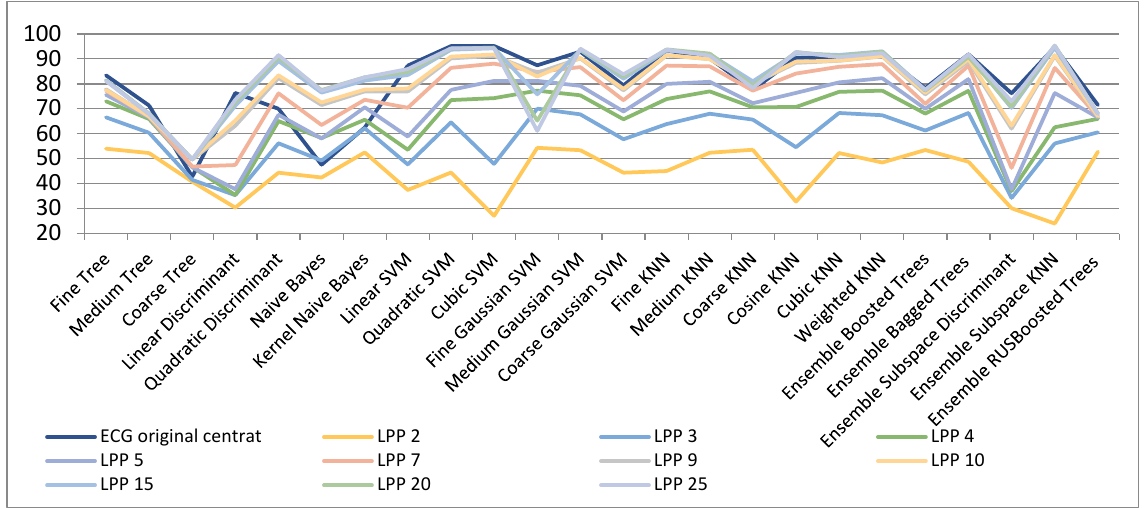
Figure 6. Classification results with LPP method for dimensionality reduction. Table 4. Classification results with LPP method for dimensionality reduction.